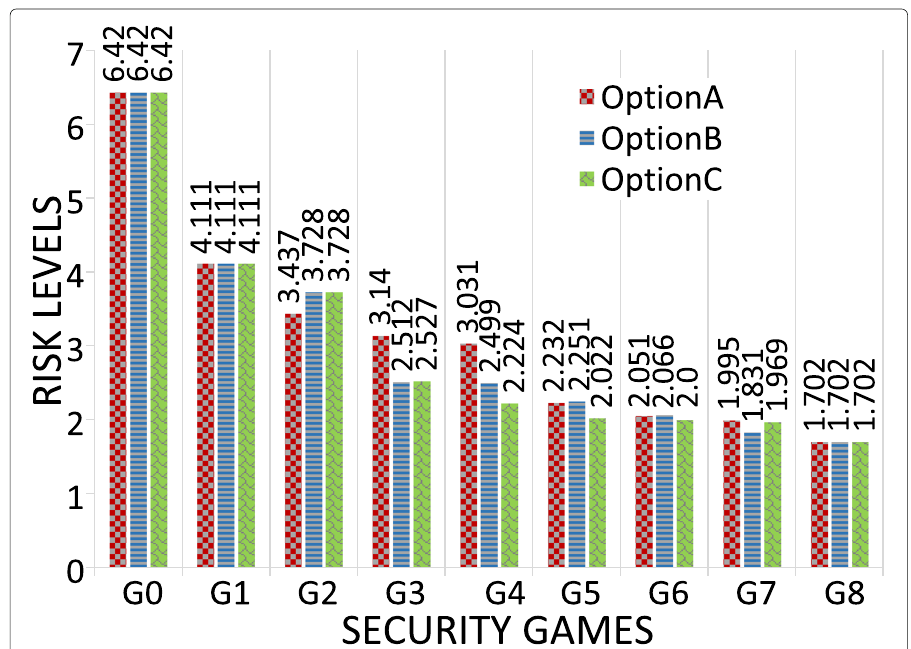
Fig. 7 The average compromise risk values of the three obtained prioritization options